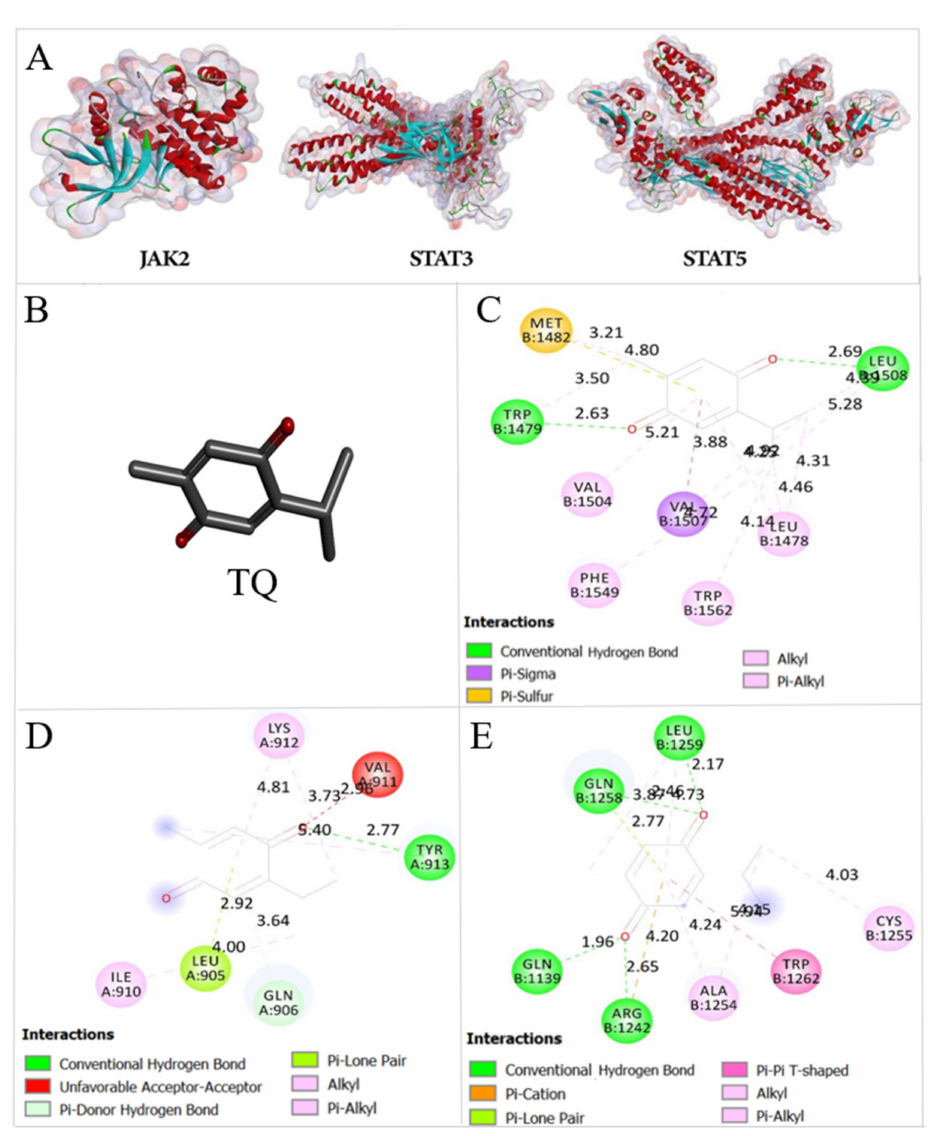
Figure 8. ( A ) JAK2 with PDB ID: 3KCK, STAT3 with PDB ID: 3CWG, and STAT5 with PDB ID: 1Y1U from the protein data bank. ( B ) Crystallography structure of TQ. The interactions between TQ and the studied proteins ( C ) JAK2 , ( D ) STAT3 , and ( E )